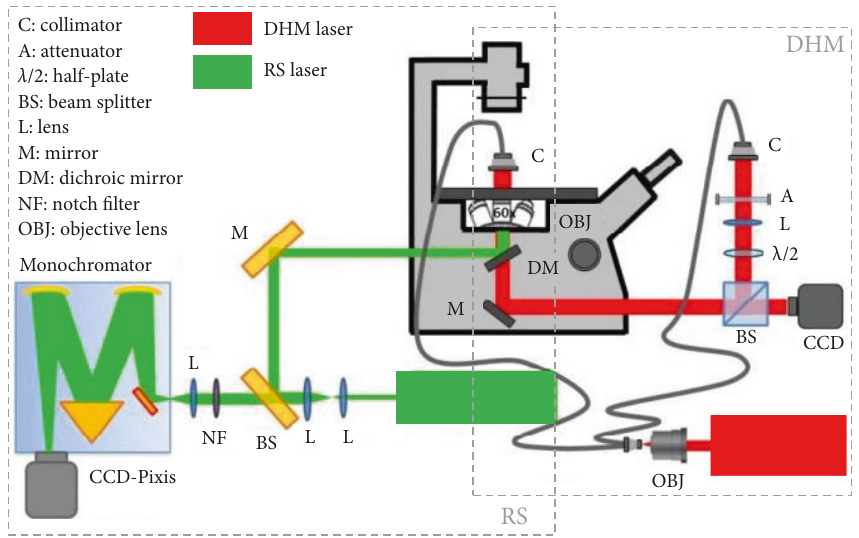
Figure 2: Experimental setup enabling the simultaneous digital holographic microscopy (DHM) and Raman spectroscopy (RS) measurements